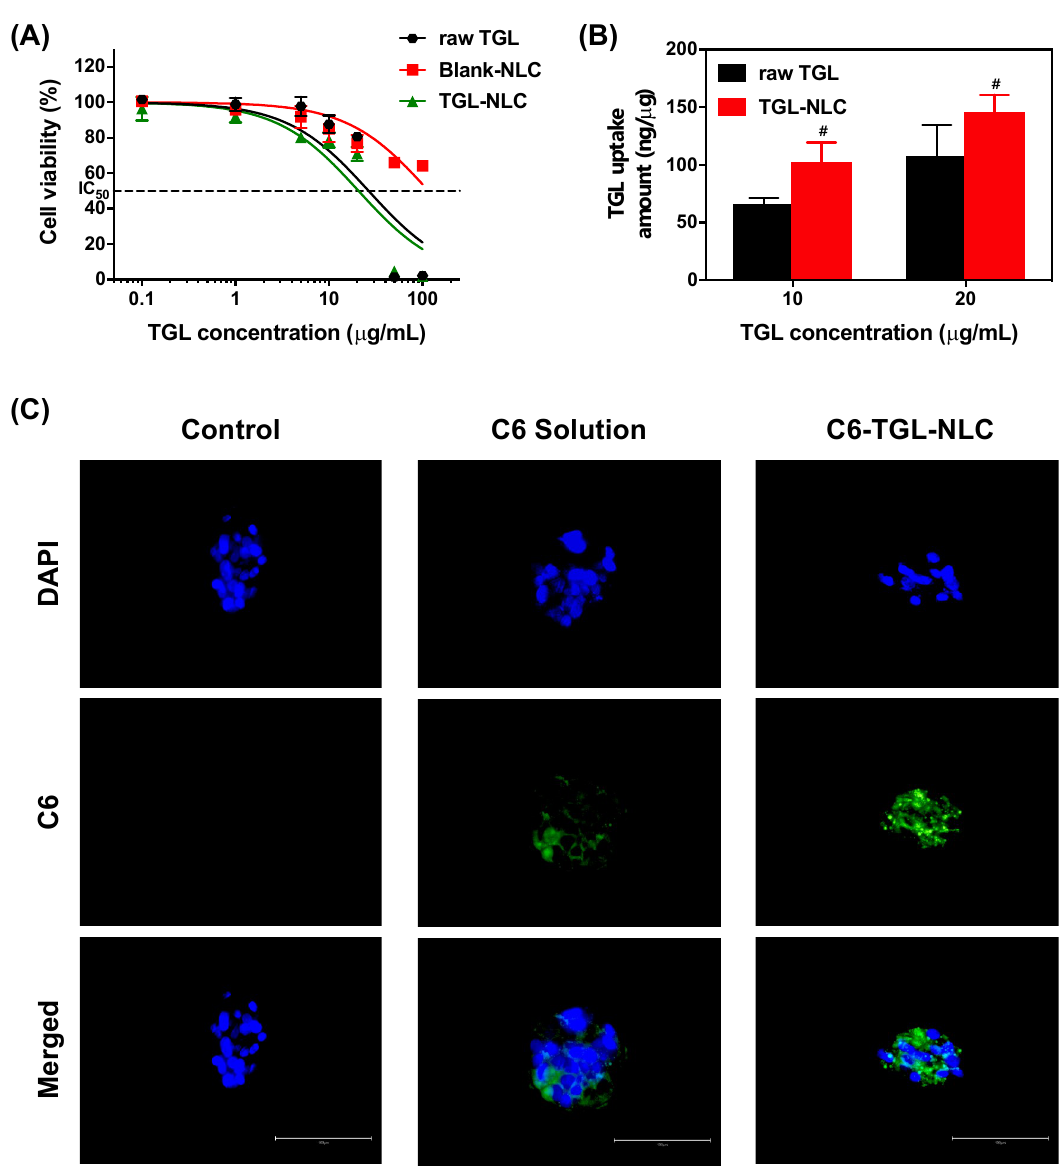
Figure 4. ( A ) Cytotoxicity of raw TGL, blank-NLC, and TGL-NLC against Caco-2 cells for 24 h. Data are expressed as the mean ± SD (n = 5). ( B ) Cellular uptake of TGL from raw TGL powder and TGL-NLC into Caco-2 cells incubated for 4 h. The TGL uptake amount was normalized by protein amount of cell lysates. Data are expressed as the mean ± SD (n = 4). # p < 0.05 vs. raw TGL at the same dose. ( C ) Cellular uptake study in Caco-2 cell lines observed with fluorescence microscope (incubated for 4 h with coumarin-6 (C6) solution and C6-TGL-NLC). Blue and green colors indicated DAPI staining and coumarin-6 (C6), respectively. The length of the white bar is 100 μm, which applies to all images including DAPI and C6 images. Abbreviation: DAPI, 4′,6-diamidino-2-phenylidone.